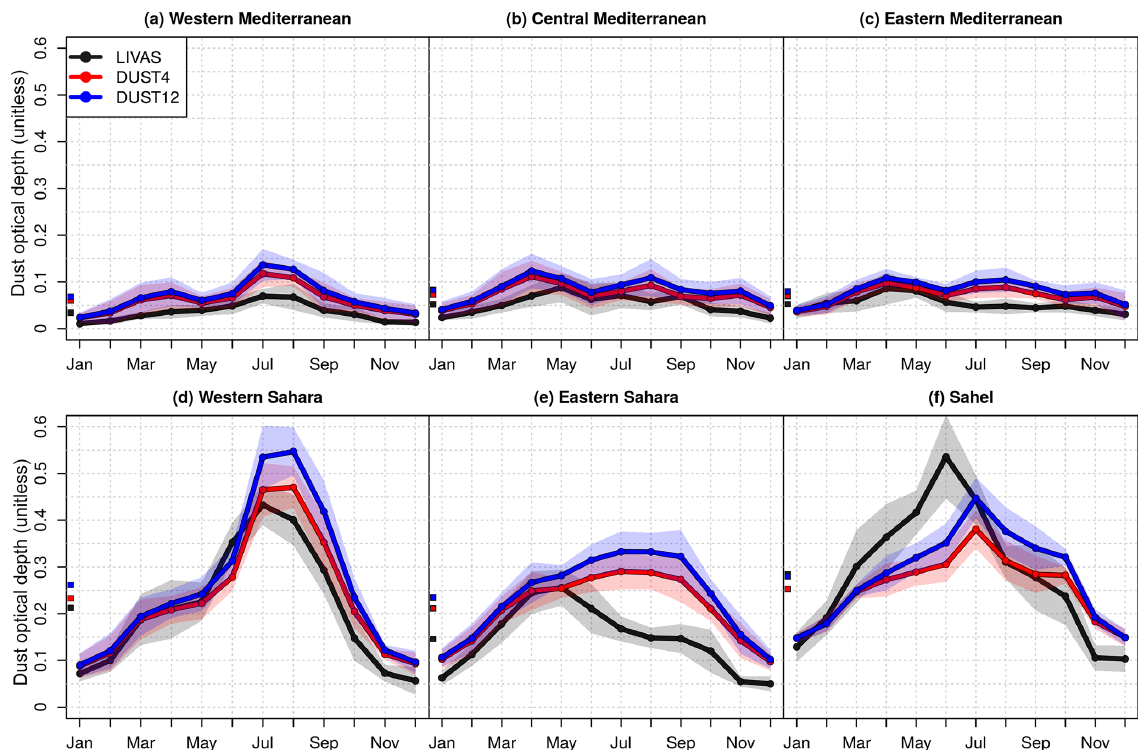
Figure 12. Annual cycle of dust optical depth of LIVAS, DUST4 and DUST12 experiments for the period December 2006 to November